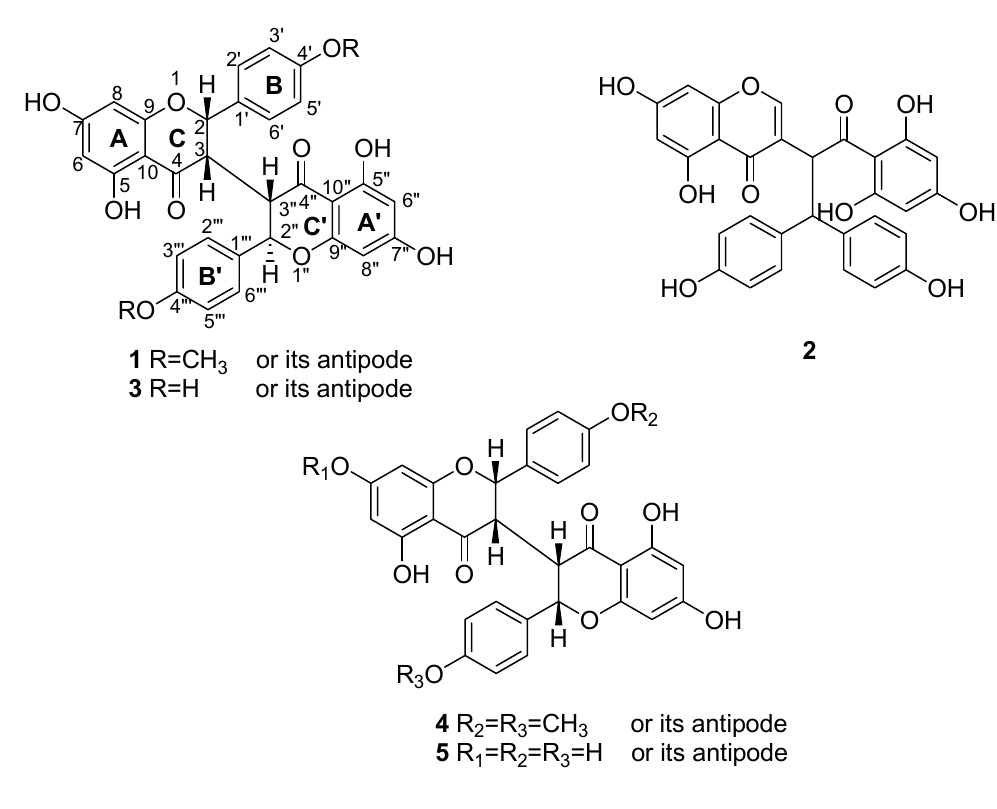
Figure 1. Chemical Structures of 1-6